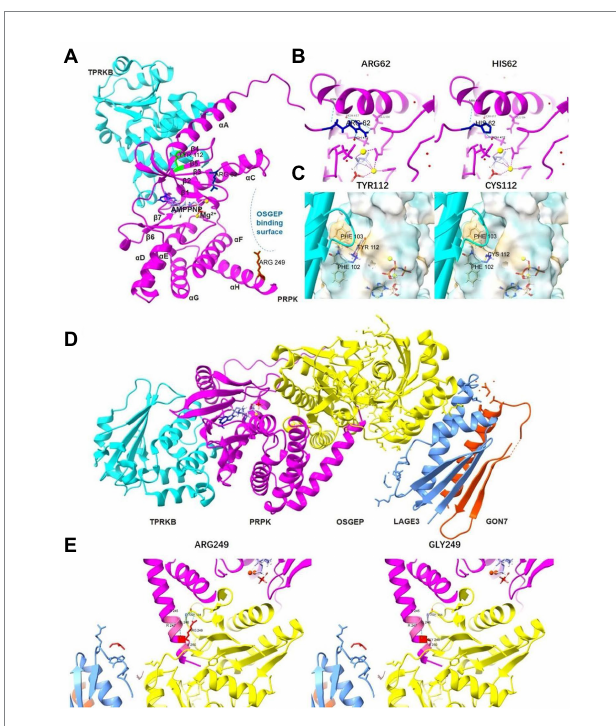
FIGURE 4 The effect of the three missense variants on the TP53RK protein. (A) The panoramic 3D map of wild-type TP53RK protein and position of mutations. (B) Prediction of the change in the 3D structure of PRPK by TP53RK R62H variant. (C) Prediction of the change in the 3D structure of PRPK-TPRKB complex by TP53RK Y112C variant. (D) The panoramic 3D map of a wild-type human KEOPS complex structural model, composed of TPRKB, PRPK, OSGEP, LAGE3, and GON7. (E) Prediction of the change in the 3D structure of KEOPS complex by TP53RK R249G